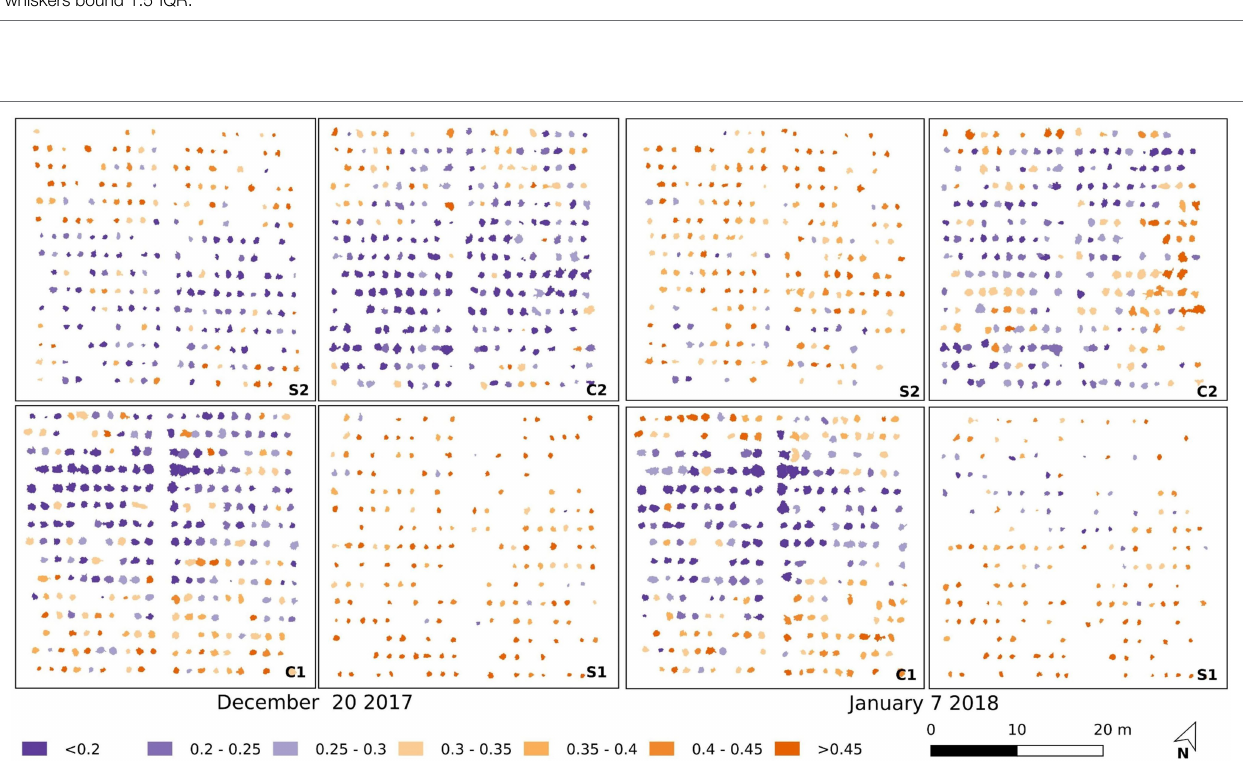
FIGURE 8 | Crop water stress index (CWSI S ) values for the simplified statistical method over both salt and control plots for four UAV campaigns throughout the growing season. The boxes span the interquartile range (IQR), with notches indicating the median and the dashed diamond the standard deviation and mean. The whiskers bound 1.5*IQR.